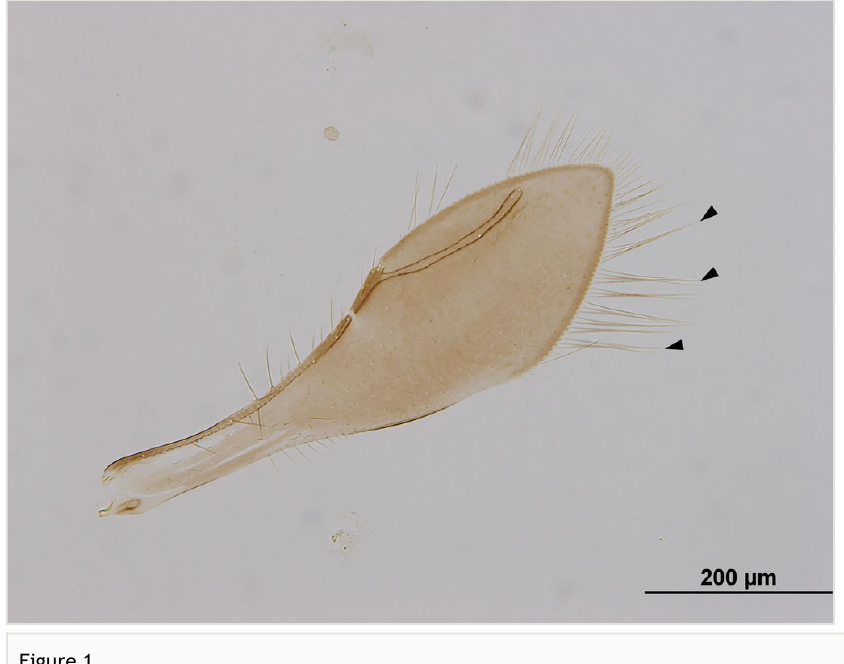
Figure 1. Bright fi eld image showing the fore wing of Pteroceraphron mirabilipennis Dessart 1981. Arrows point to elongate marginal